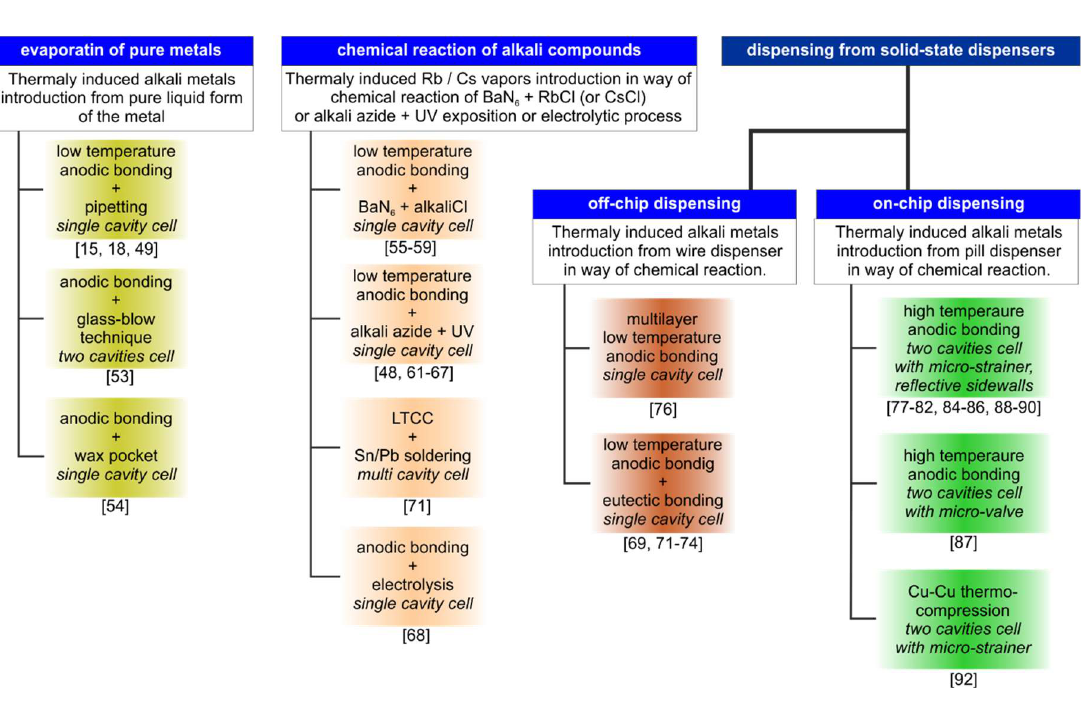
Figure 1. Fabrication “family tree” of alkali microelectromechanical systems (MEMS) cells.